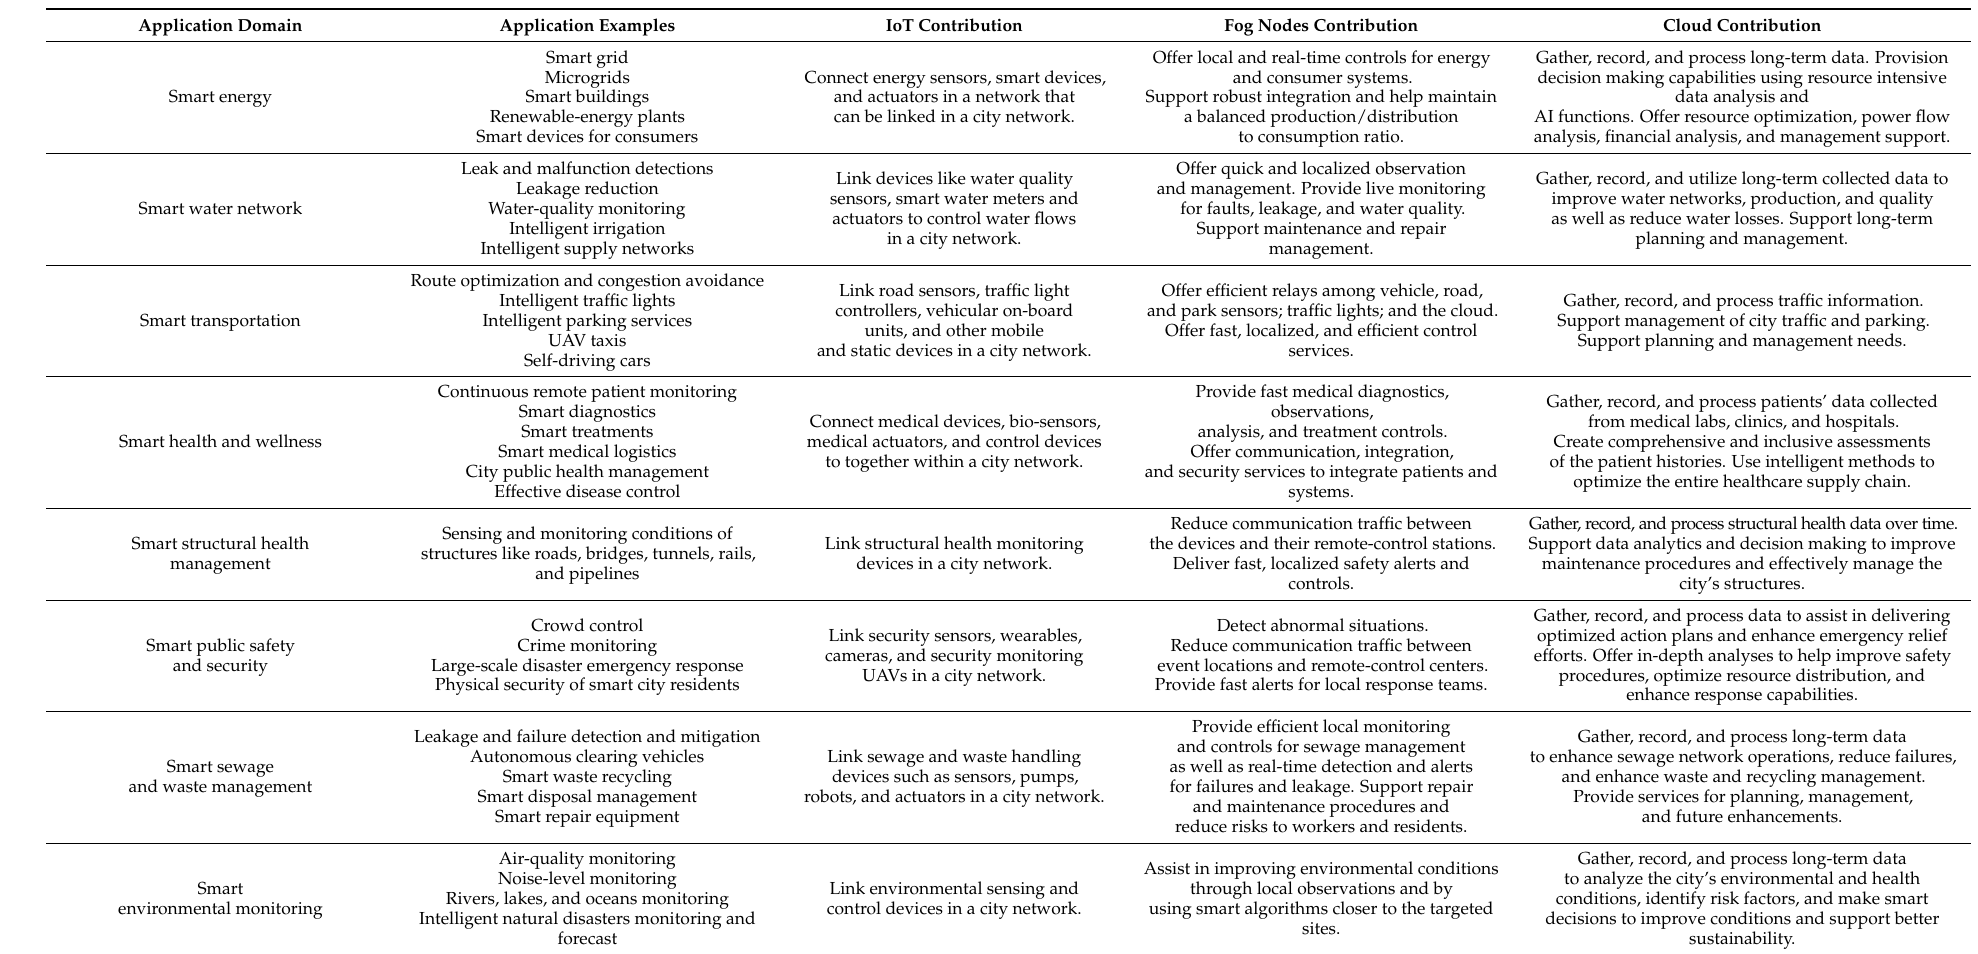
Table 1. Smart City Applications that can benefit from an iIFCs